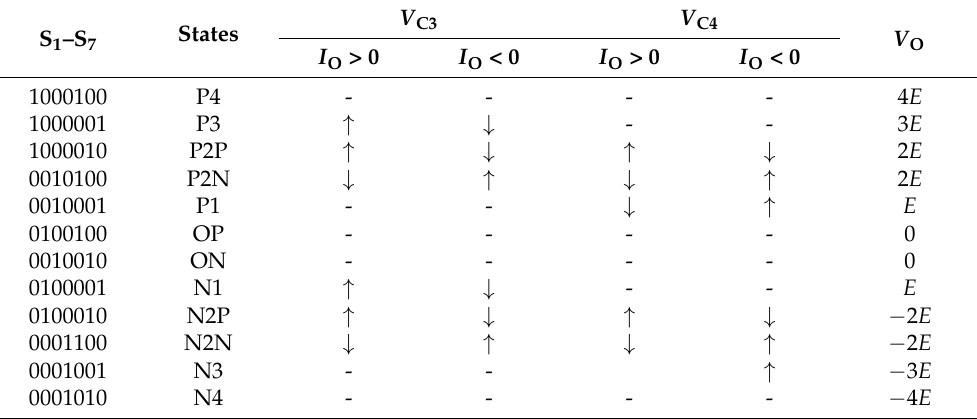
Table 1. Switching states of the proposed 9-level converter.